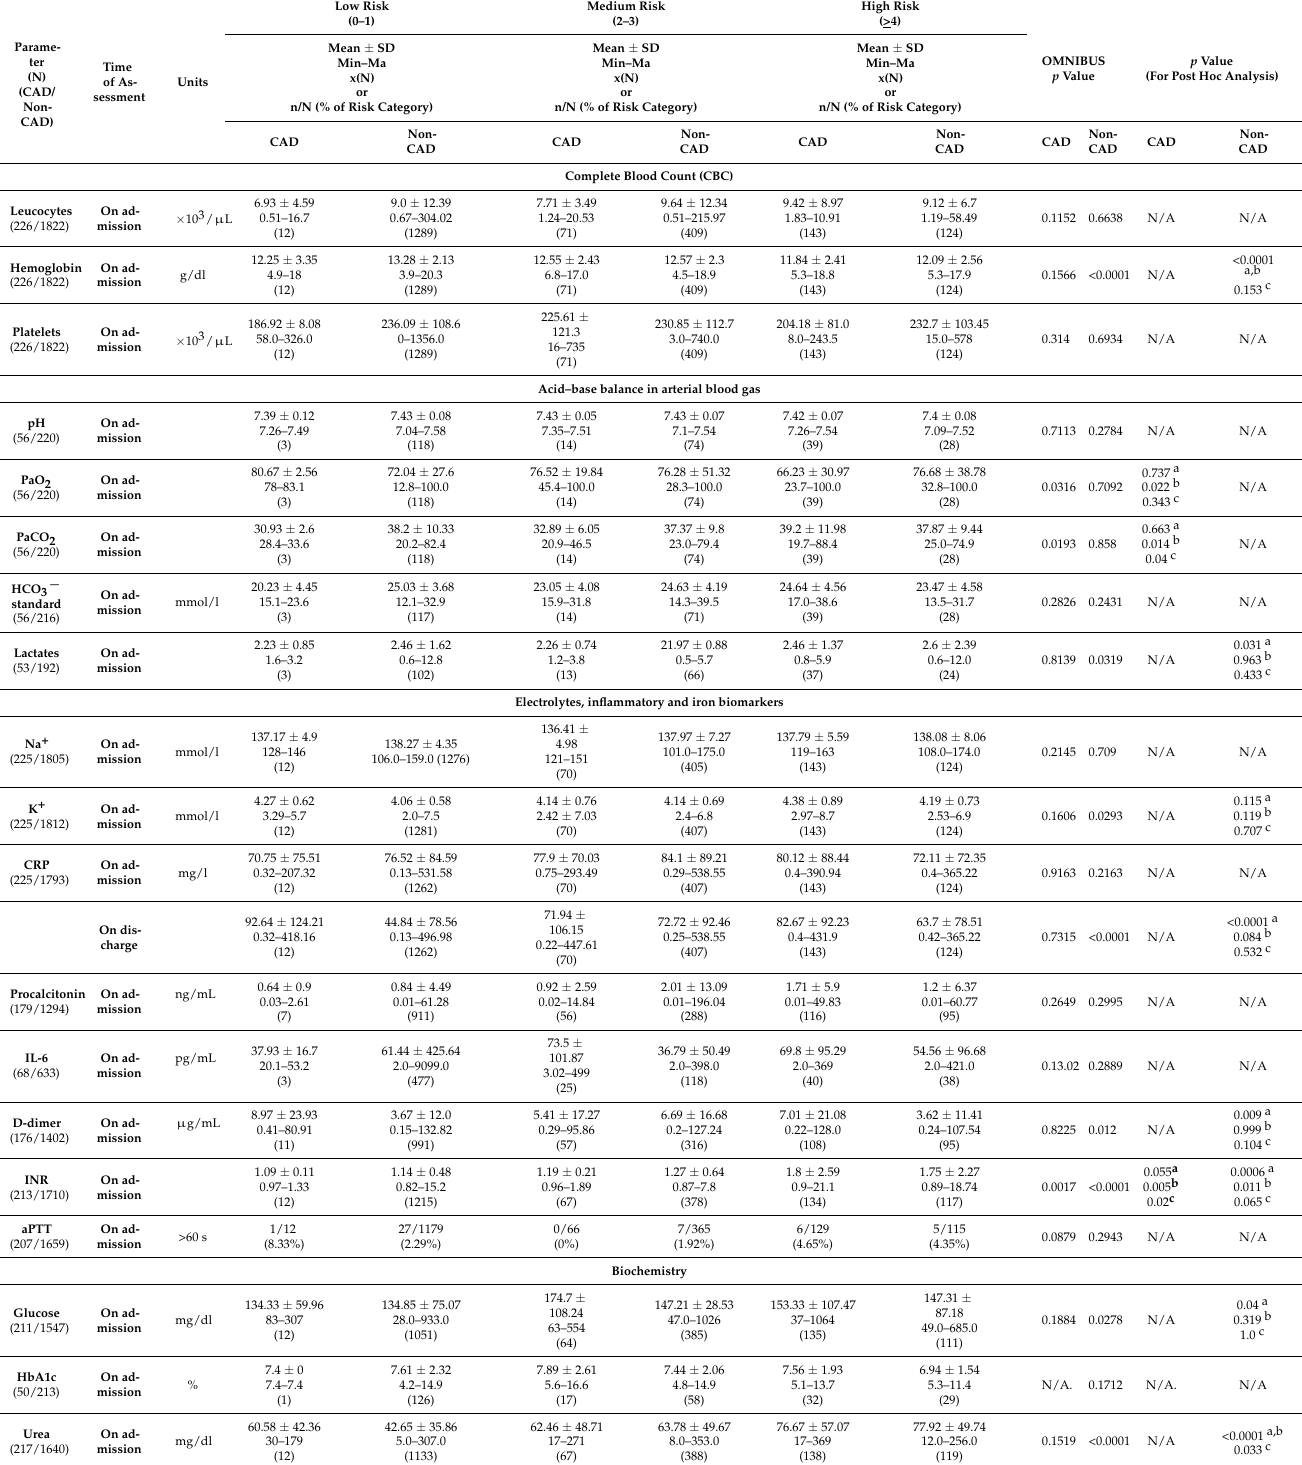
Table 4. Laboratory parameters measured during hospitalization in the studied